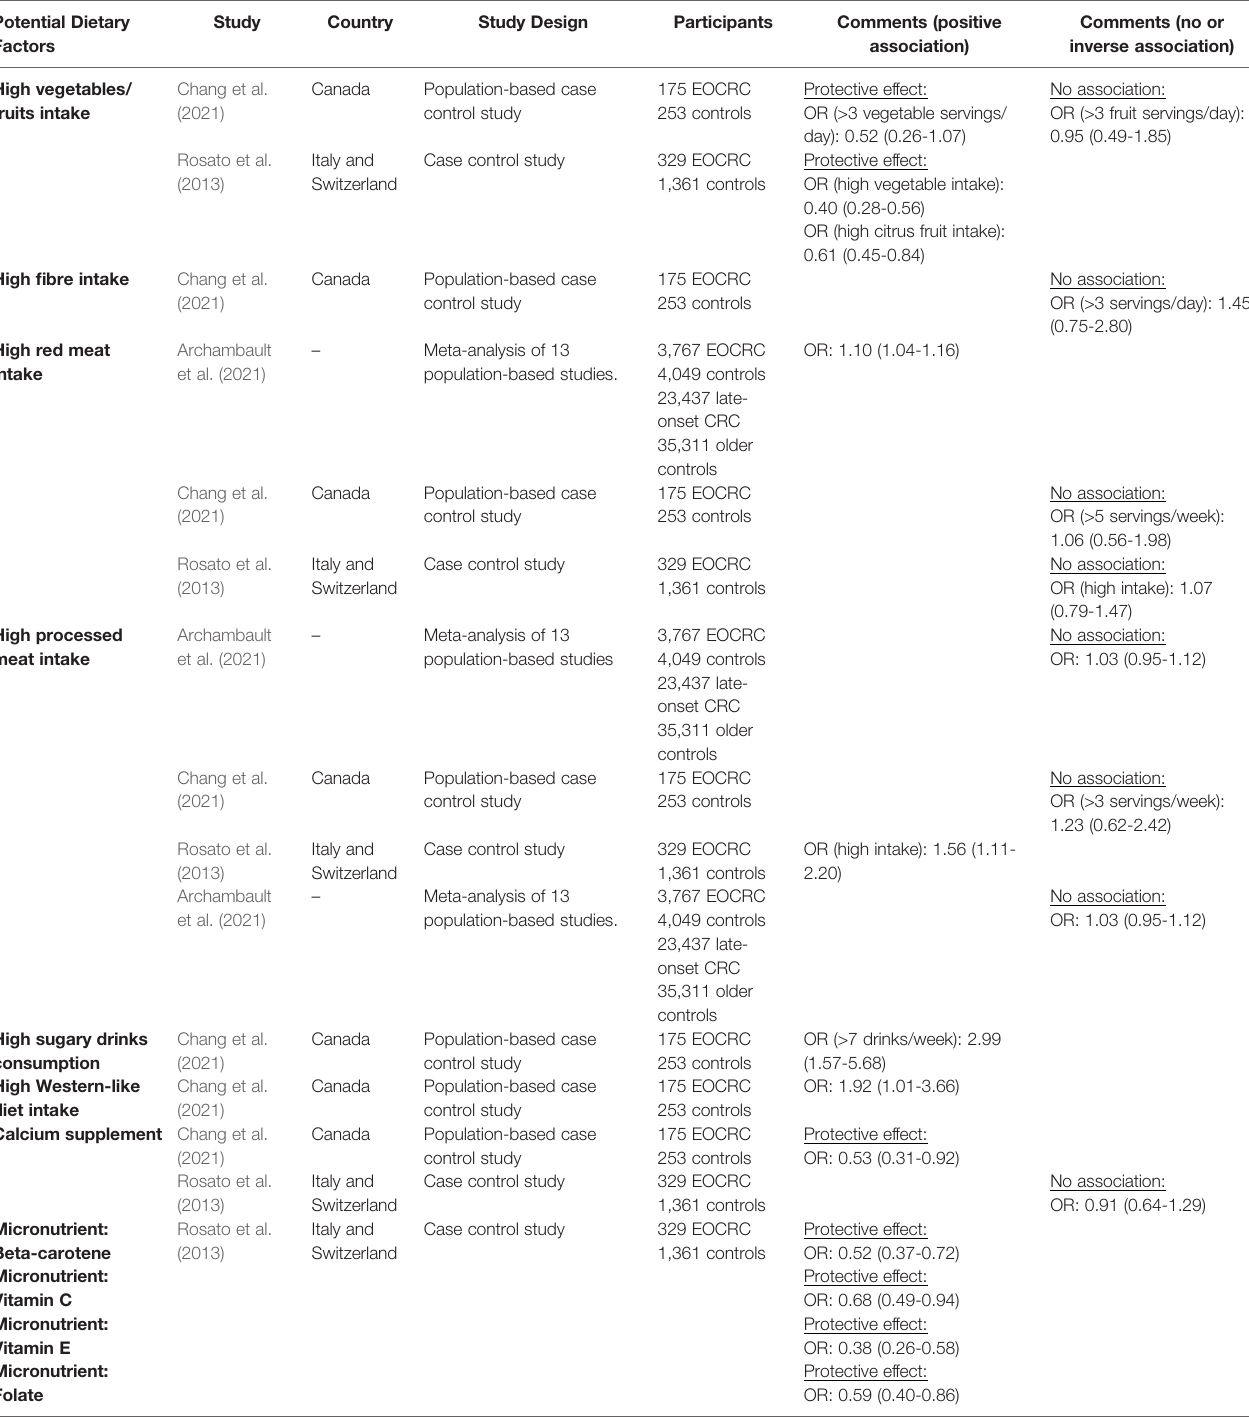
TABLE 2 | Recent published studies on the dietary factors for